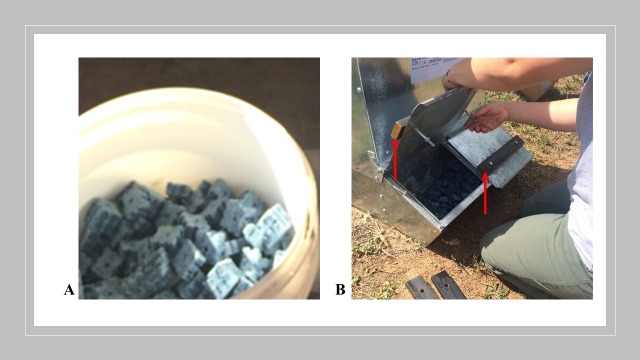
(A) Paraffin extruded wax blocks containing 0.005% warfarin; and (B) commercial pig feeder with custom-built ~4.5 kg weights attached to doors (red arrows) to limit non-target access.